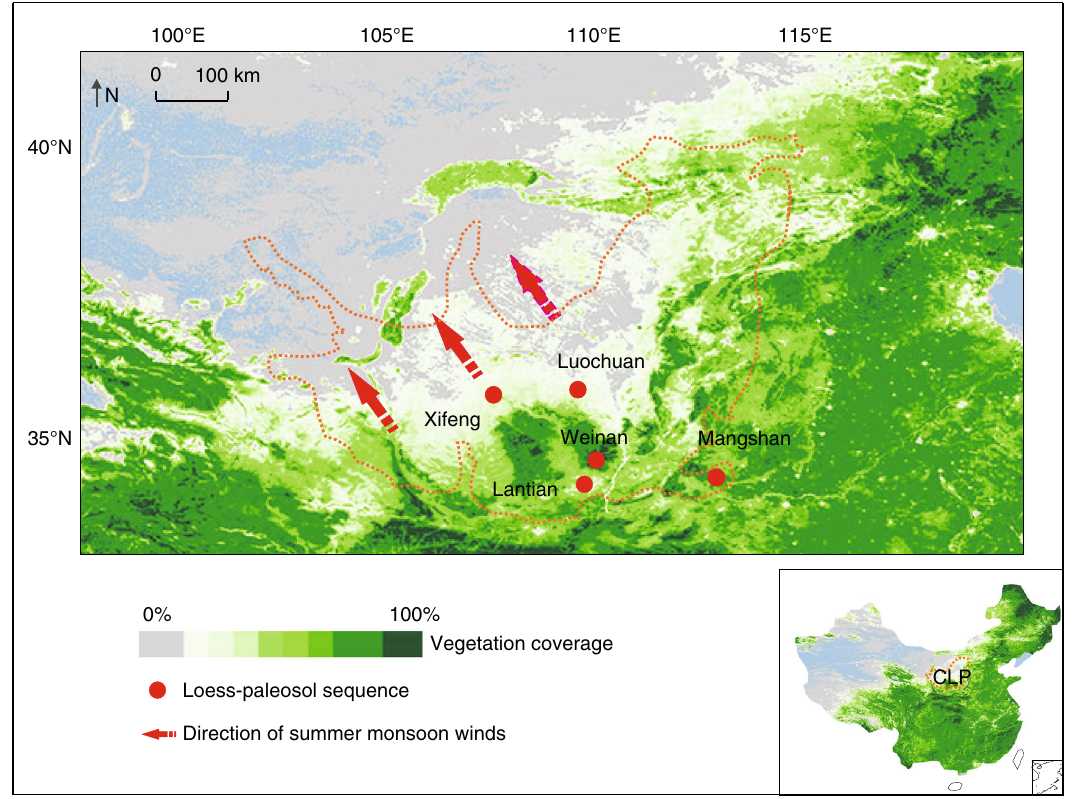
Fig. 1 Geographic locations of Mangshan, Lantian, Weinan, Luochuan, and Xifeng loess – paleosol sections and modern vegetation coverage on the Chinese Loess Plateau. The base map is generated from the ArcGIS software. Vegetation coverage was calculated from the annual maximal Normalized Difference Vegetation Index of the SPOT VEGETATION satellite dataset as proposed in ref. 50 . The area enclosed in orange line denotes the Chinese Loess Plateau. Modern vegetation coverage on the plateau decreases from southeast to